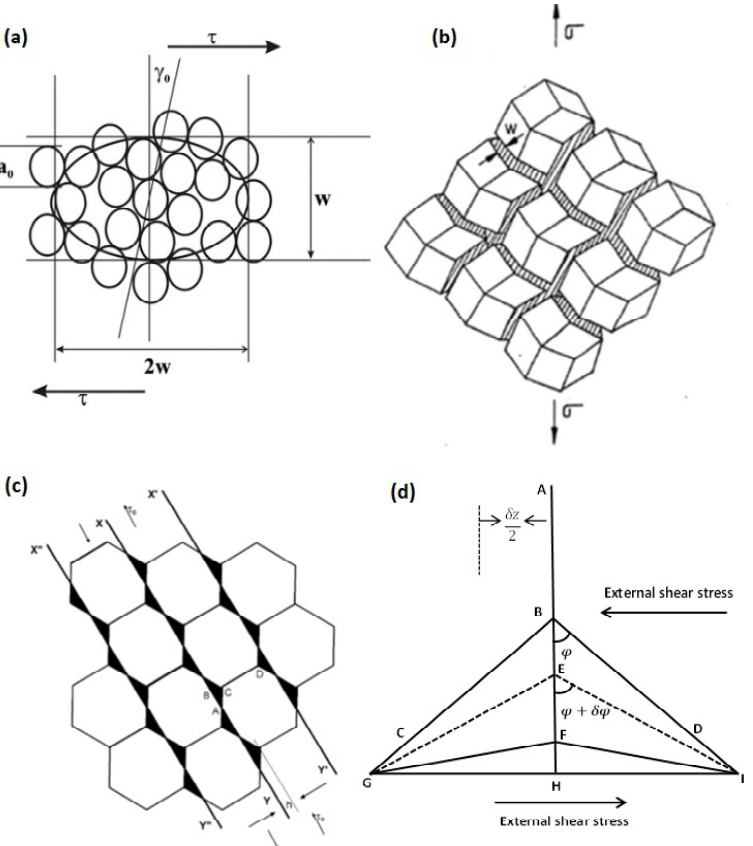
Fig. 2. (a) Basic boundary sliding unit containing free volume. (b) Assuming a rhombic dodecahedral grain shape (closest to the shape of real crystals, see our works [8,21]) the grain boundary regions within which the rate-controlling process is confined are shown shaded. (c) Plane interfaces (the ones like XY , X ’ Y ’, X ’’ Y ’’ etc.) formed by mesoscopic boundary sliding when the atoms located in the shaded regions are moved by the external stress in such a way to extend the boundaries normal to the shear direction to reach the sliding boundary and form a plane interface, (d) an illustration, based on Herring’s theory for equilibrium at a triple junction, which illustrates the extension downward of the boundary perpendicular to the external stress axis (AB to AH) to decrease the overall free energy of the system. In the process a plane interface gets formed (adapted from